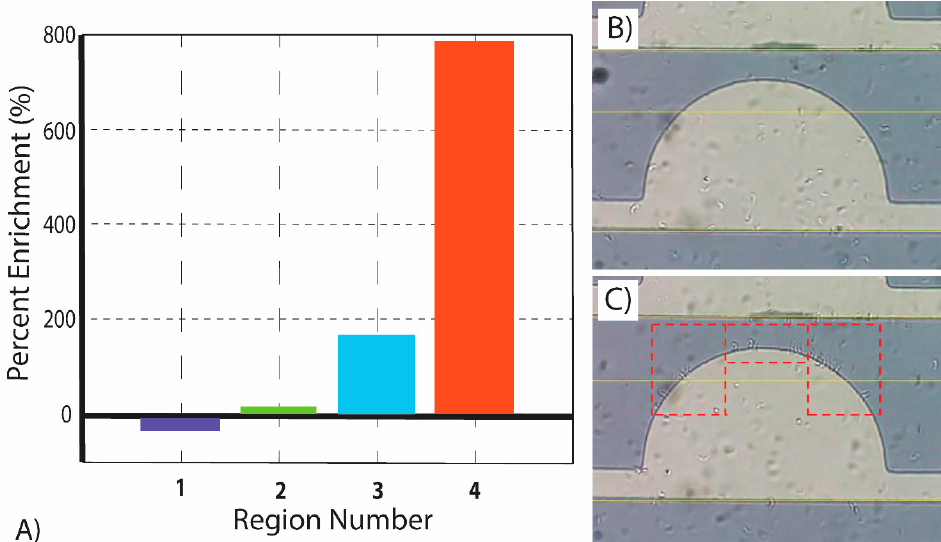
Figure 5. ( A ) Regional enrichment study of parasites from time t = 0 to t = 50 s for four